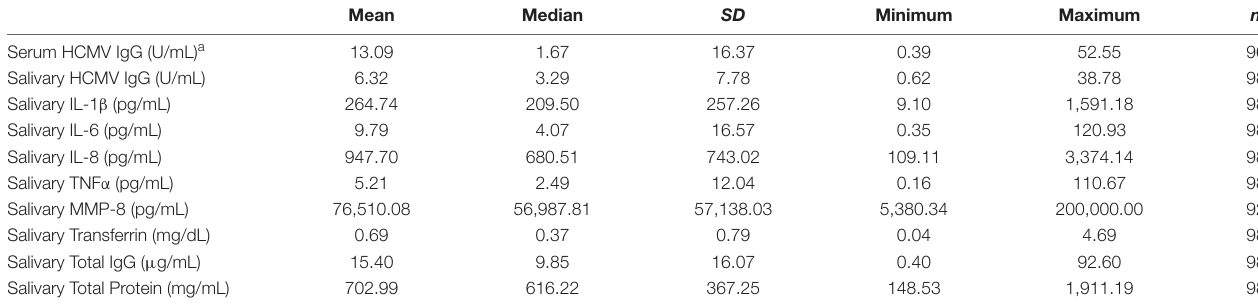
TABLE 2 | Descriptive statistics of biomeasures from a sample of healthy adults. Mean Median SD Minimum